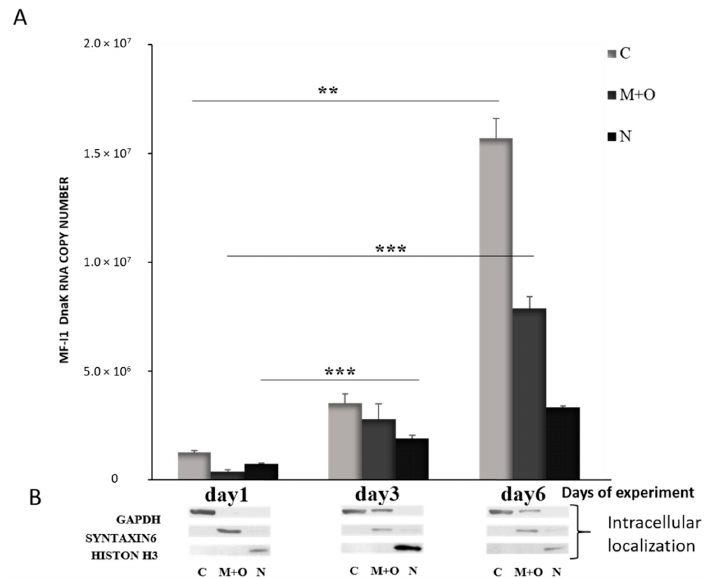
Figure 3. Quantification of dnaK RNA copy number in different intracellular compartments of HCT116 infected with M. fermentans MF-I1. ( A ): After the indicated days of experiment, RNA was collected from the different cellular compartments, and subjected to qRT-PCR analysis. ( B ): Western blot was performed to confirm proper fractionation of cell compartments. GAPDH was used as a marker for cytosol, Syntaxin 6 was used to label the membrane compartment and organelles and H3 for the nucleus. Data represent the mean values ± S.E. of samples run in triplicate and are representative of data from three different experiments. The p -values were calculated by two sample t -test. ** = p -value between 0.05 and 0.01; *** = p -value < 0.01. Cellular compartments are indicated as follows: C; Cytoplasm; M + O: Mitochondria + organelles; N: